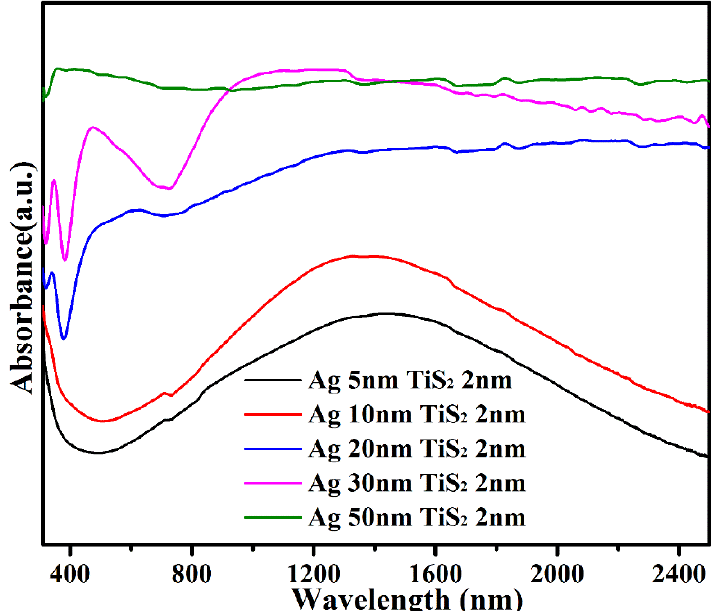
Figure 8. UV–Vis–NIR spectra for the Ag (t = 5, 10, 20, 30, 50 nm)/TiS 2 (2 nm) nanostructures.